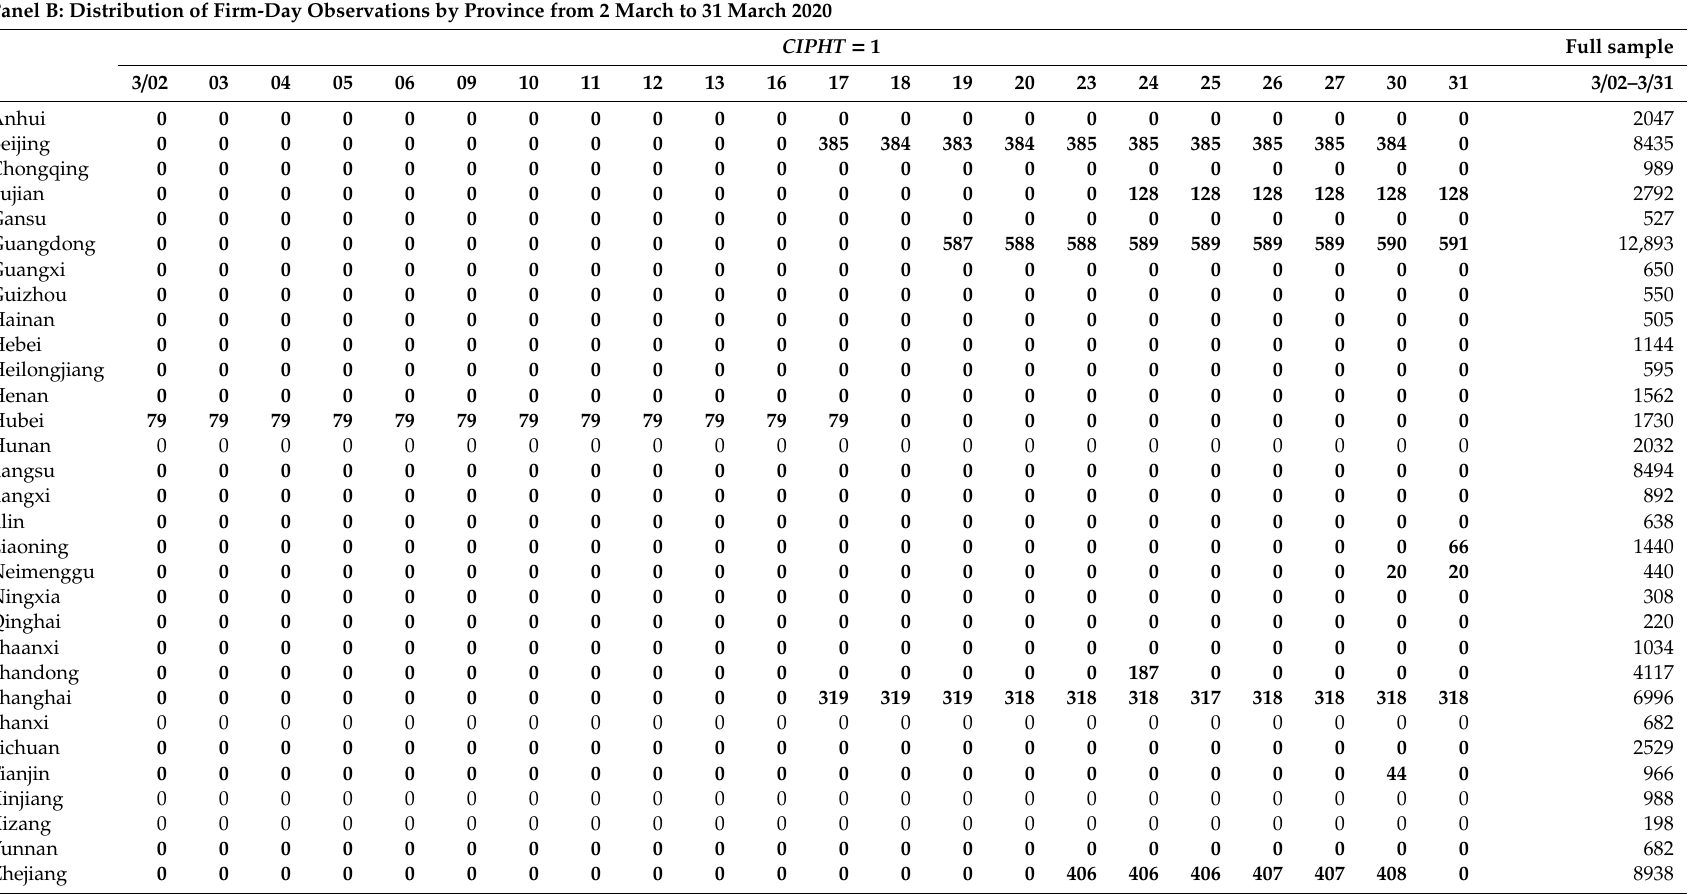
Panel B: Distribution of Firm-Day Observations by Province from 2 March to 31 March